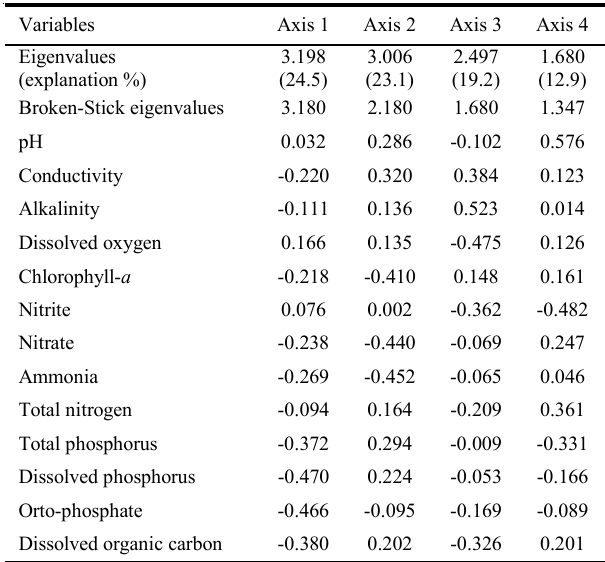
Table 2. Results of principal components analysis (PCA) ap- plied for chemical variables.